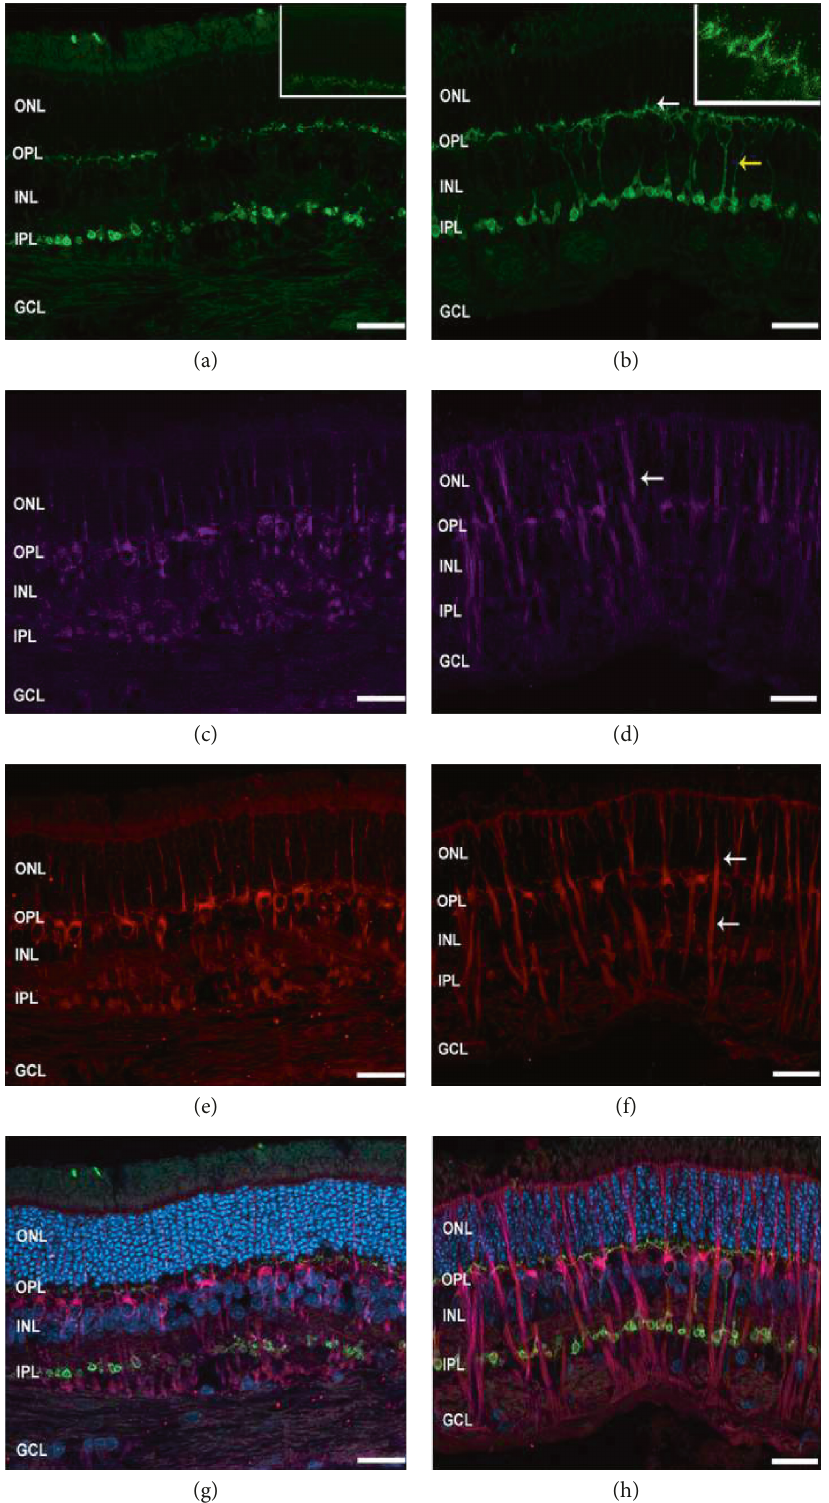
Figure 7: Remodeling of bipolar cells in a control (left column) and in a detached retina (right column). Representative images of retinal sections labelled with PKC for mixed bipolar cells ((a), (b), green), mGluR6 for on bipolar cells ((c), (d), purple), and iGluR4 for o ff bipolar cells ((e), (f), red). Merged images are illustrated, counter stained with DAPI ((g), (h), DAPI-blue). IS=inner segment, OS =outer segment, ONL=outer nuclear layer, INL =inner nuclear layer, OPL=outer plexiform layer, INL =inner nuclear layer, IPL =inner plexiform layer, and GCL=ganglion cell layer. Original magni fi cation × 20, enlarged images of (a) and (b) at × 63 magni fi